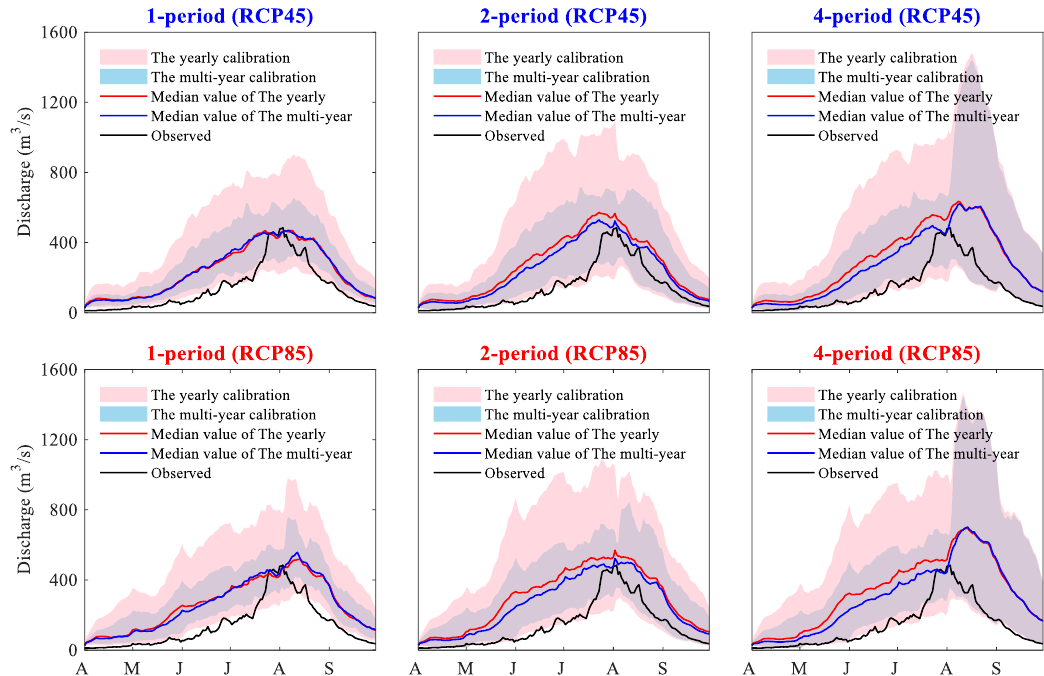
Figure 8. The 95% uncertainty intervals for the GCM–srm predicted daily discharge (Period 2041–2050). The bottom and top of the colored intervals represent the 2.5th and 97.5th percentile values, respectively. In each subplot, the pink and blue shadings represent the yearly and the multi-year calibration strategies, respectively. Median values of the pink and blue envelopes are shown as the red and blue curves, respectively.